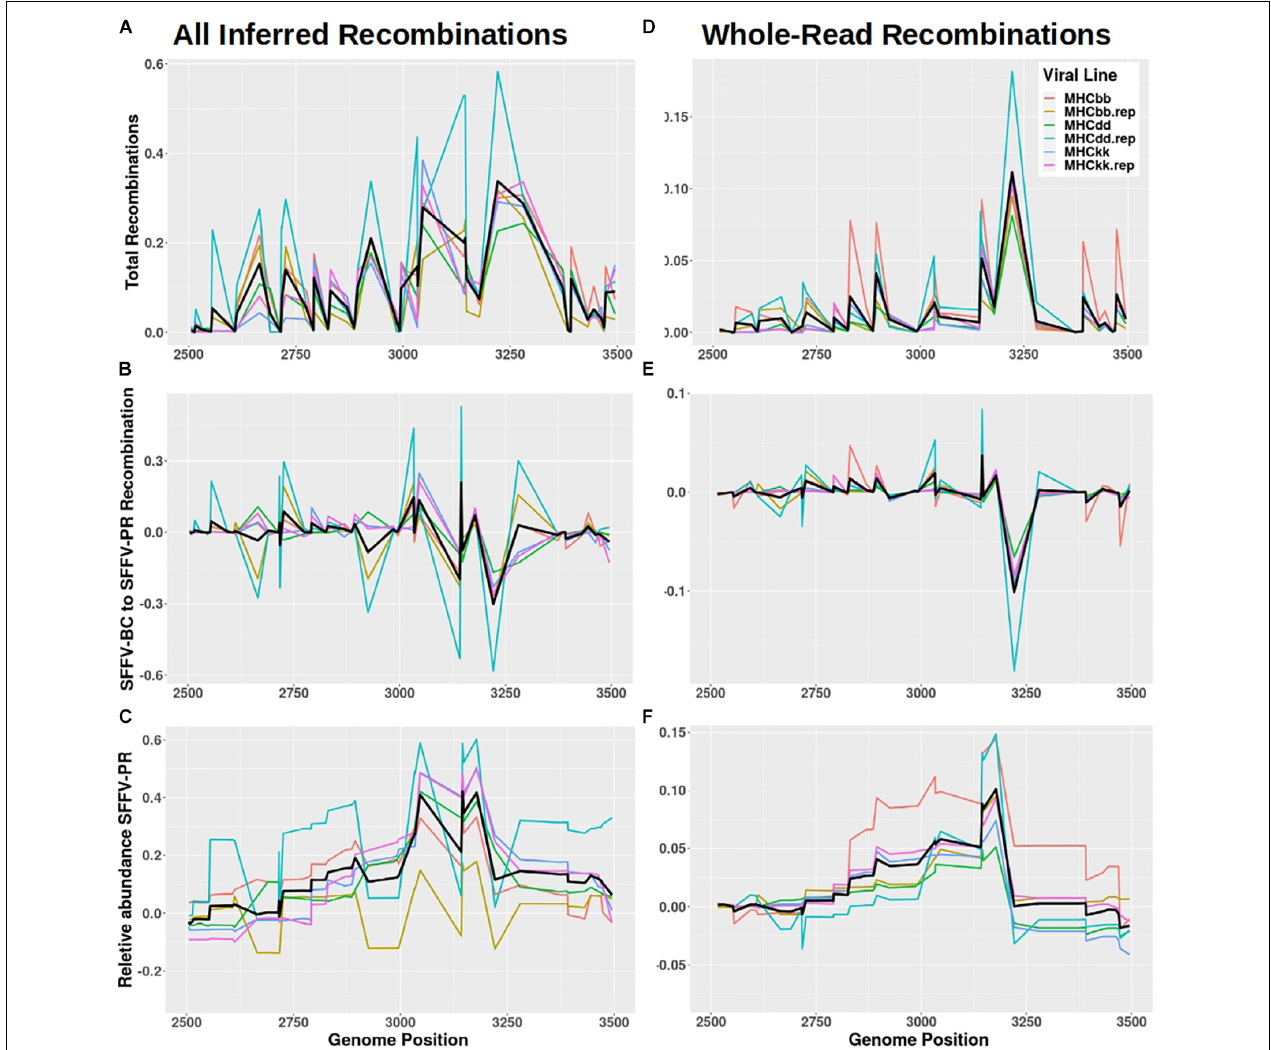
FIGURE 6 | SFFV/ERV recombinants detected in SFFV viral reads. (A,D) The total frequency of recombinations, (B,E) the frequency of net SFFV-BC to ERV recombinations, and (C,F) a rolling sum of net SFFV-BC to ERV recombinations (i.e., the frequency of Polytropic MuLV sequences across the genome inferred by detected recombinations) are all plotted against the SFFV-BC genome. Panels (A–C) depict all inferred recombinations while (D–F) counts only reads which had a single inferred recombination. Colors denote the six independent passage lines with the average values plotted in